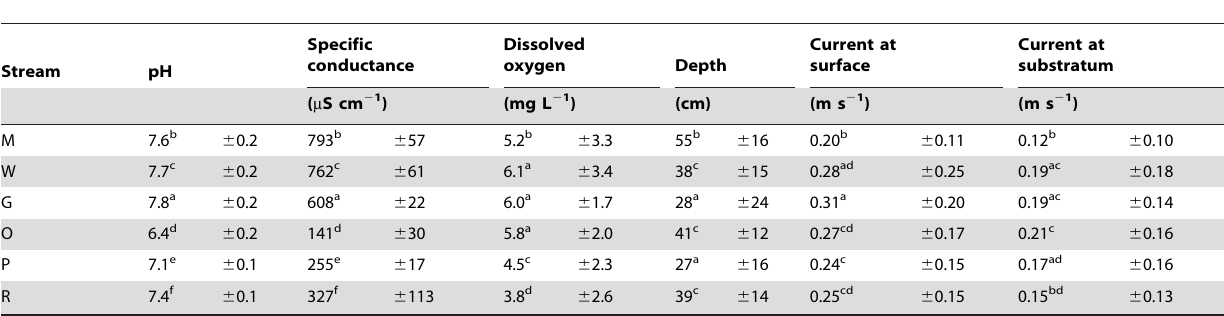
Table 1. Physico-chemical properties of the study sites.